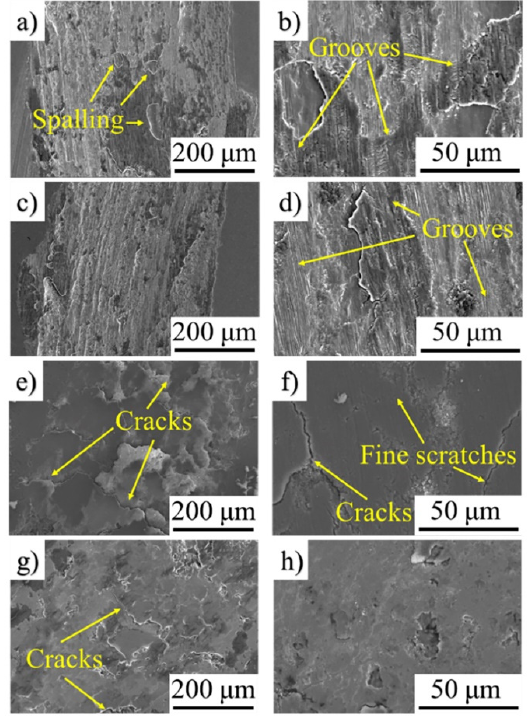
Figure 11. The SEM images of the wear tracks: ( a , b ) S1, ( c , d ) S2, ( e , f ) C1, ( g , h ) C2.